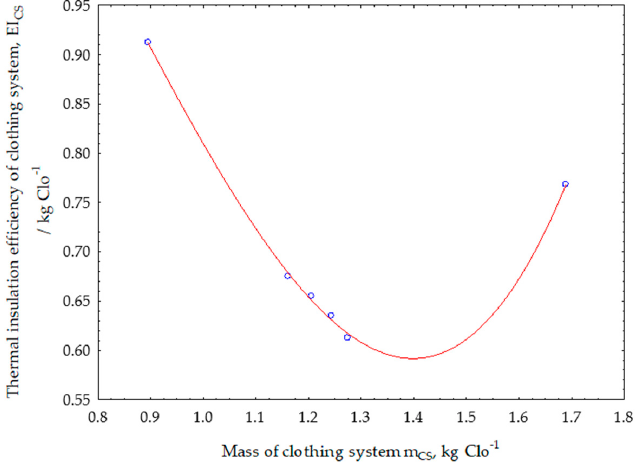
Figure 7. Functional dependence on changes in the values of the parameters of thermal insulation efficiency of clothing systems.